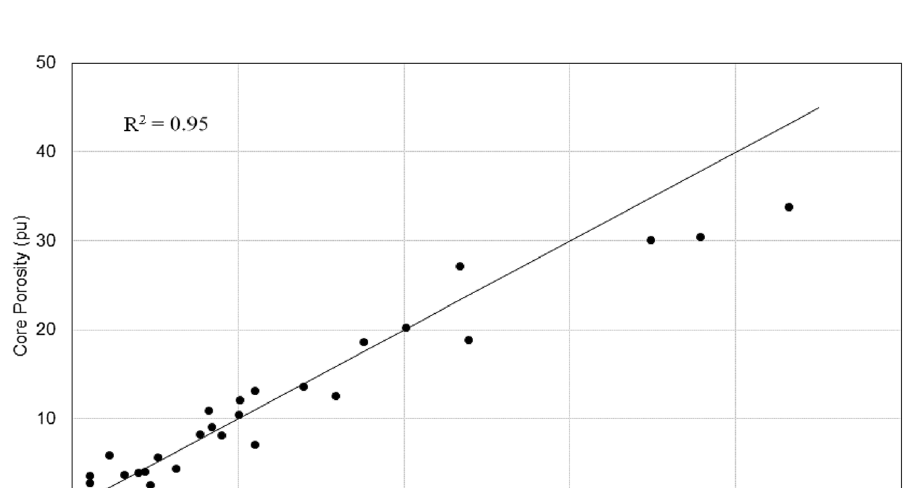
Fig. 5 NMR and core porosity